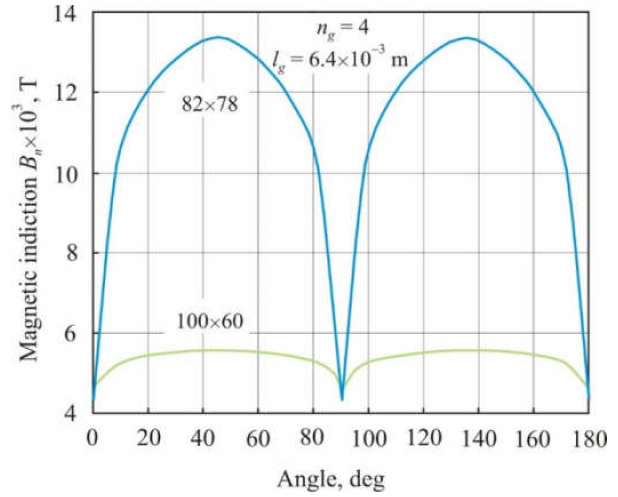
Figure 9. Distribution of normal magnetic induction B n averaged over the cross-section of annular cores 100 × 60 mm and 82 × 78 mm depending on the angular coordinate. The cores have the same mean magnetic path length l = 0.08 m, the total air gap length l g = 6.4 × 10 − 3 m, and the number of gaps n g =